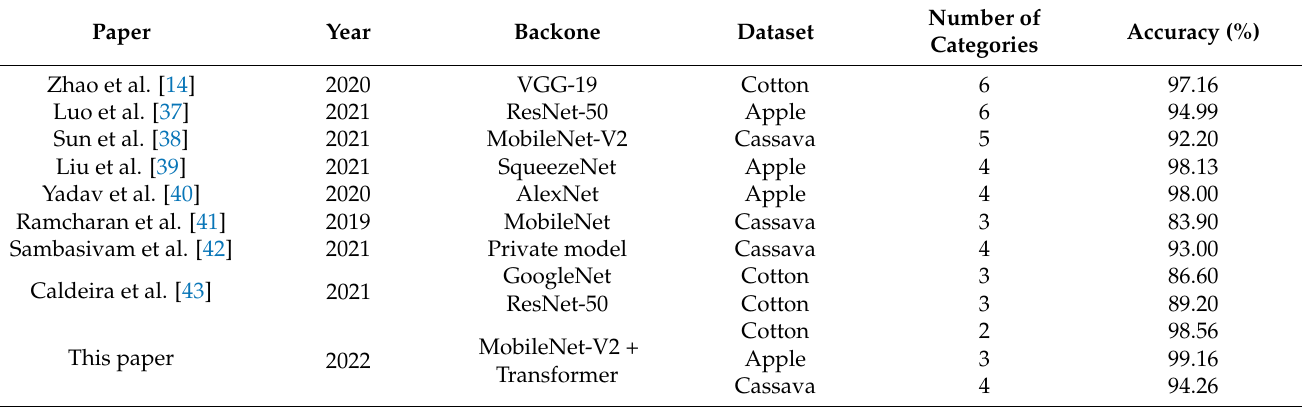
Table 6. Comparisons with results from other